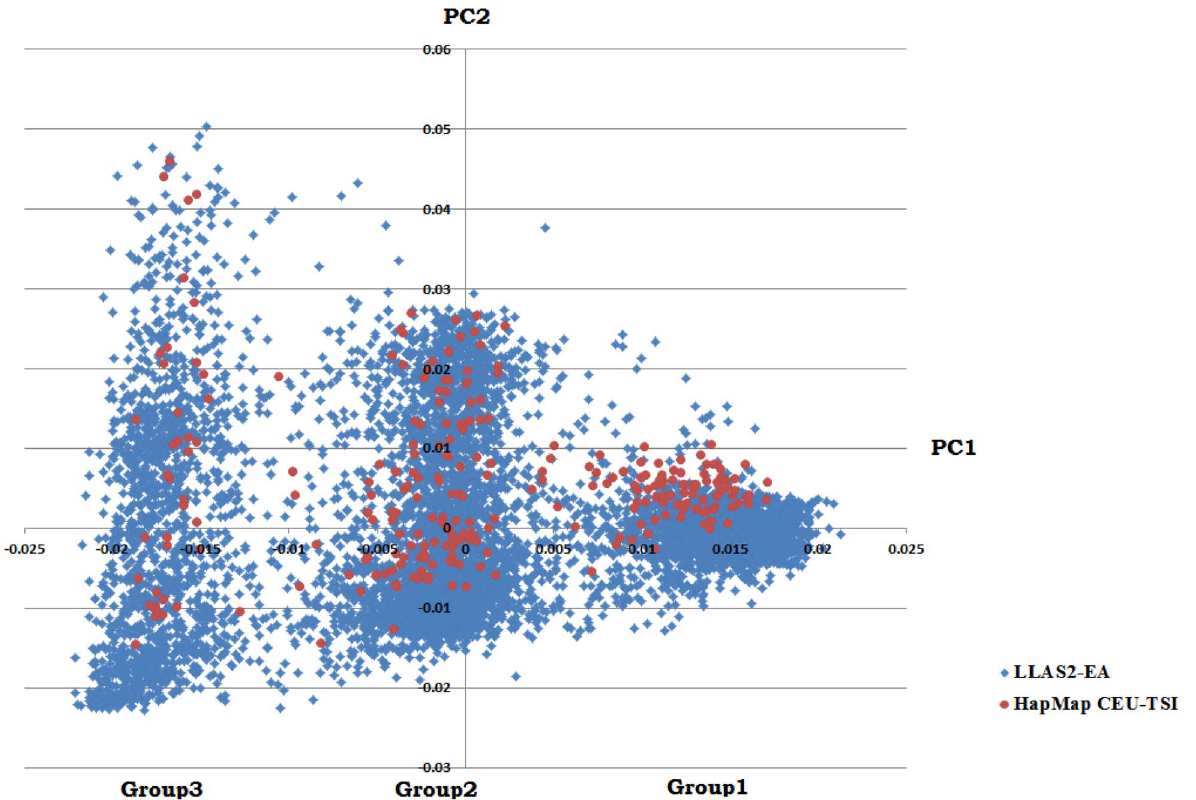
Fig. 1. PCA analyses on 7683 Caucasian derived samples and identification of three subgroups at 8p23. Group 1 5 Inverted-homozygous, Group 2 5 Heterozygous, Group 3 5 Non-inverted